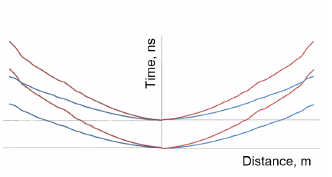
Figure 8. UE possible composition from one standard EAS de- layed from another.